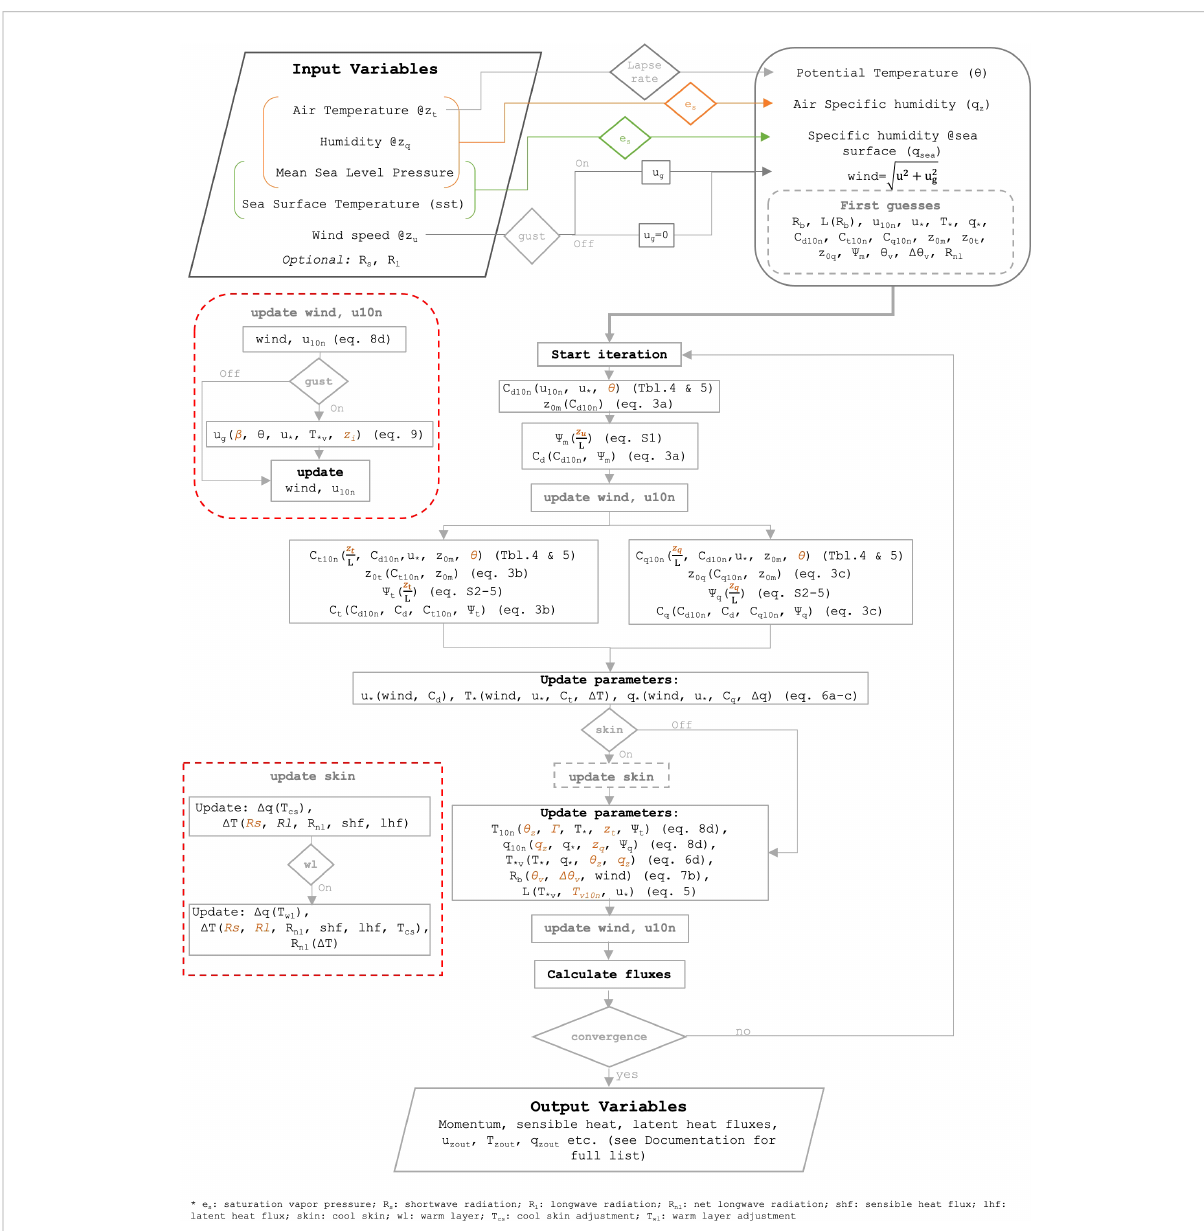
FIGURE 3 Schematic of AirSeaFluxCode ’ s implementation. The main dependencies for each variable are shown in parenthesis. Inside the parenthesis variables that are not updated during the iteration are shown in colored